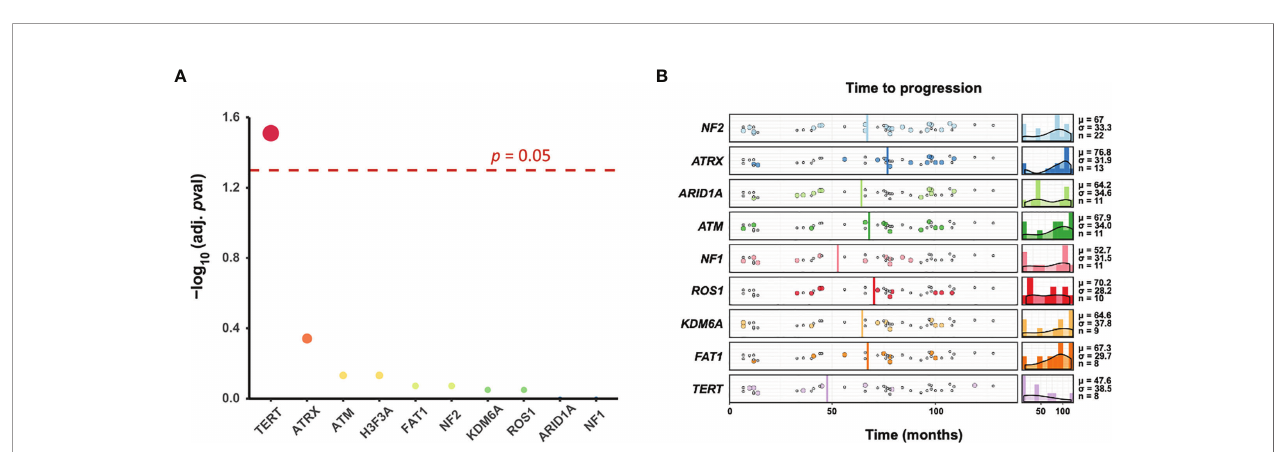
FIGURE 2 | Recurrent mutations in de novo high-grade meningioma (HGM) patients with and without progression after adjuvant radiotherapy (RT). Top 9 genes with most frequent mutations are depicted. Each column corresponds to a single patient. The colors of bars are indicative of the type of mutation, with gray indicating wild type. Barplot at the top of the fi gure represents the status a patient has. The vertical plot on the right of the fi gure represents the frequency of mutations in each gene in a decreasing manner.